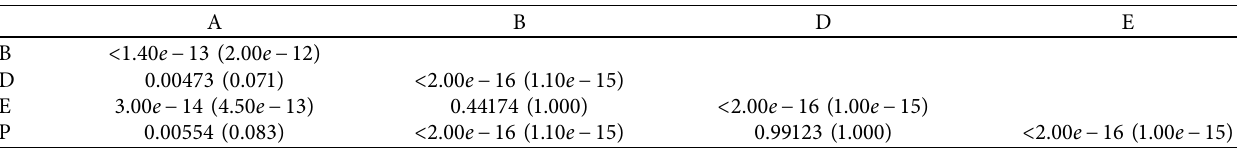
Table 8: In L-Space, for Kolumbus network, pI � 0.05, pR � 0.0025, and T � 150, p -value of the Wilcoxon rank sum test (resultant p -value per Bonferroni correction is indicated in brackets).